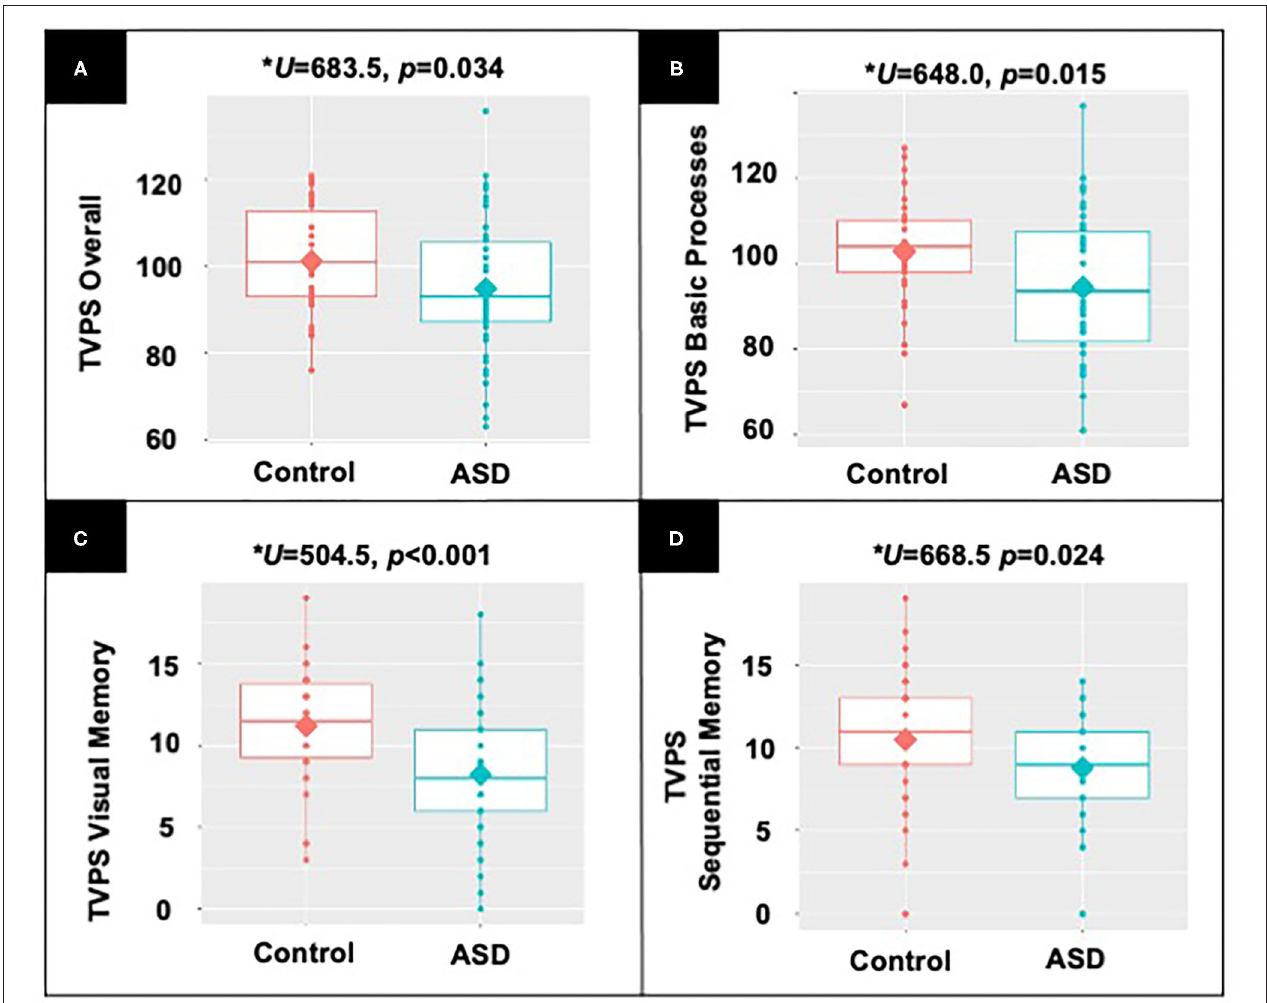
FIGURE 2 | Results from non-parametric, Mann-Whitney U -demonstrating differences between participants with and without ASD in (A) TVPS Overall index scores; (B) TVPS Basic Processes subtest scores; (C) TVPS-VM subtest scores; and (D) TVPS-SM subtest scores.